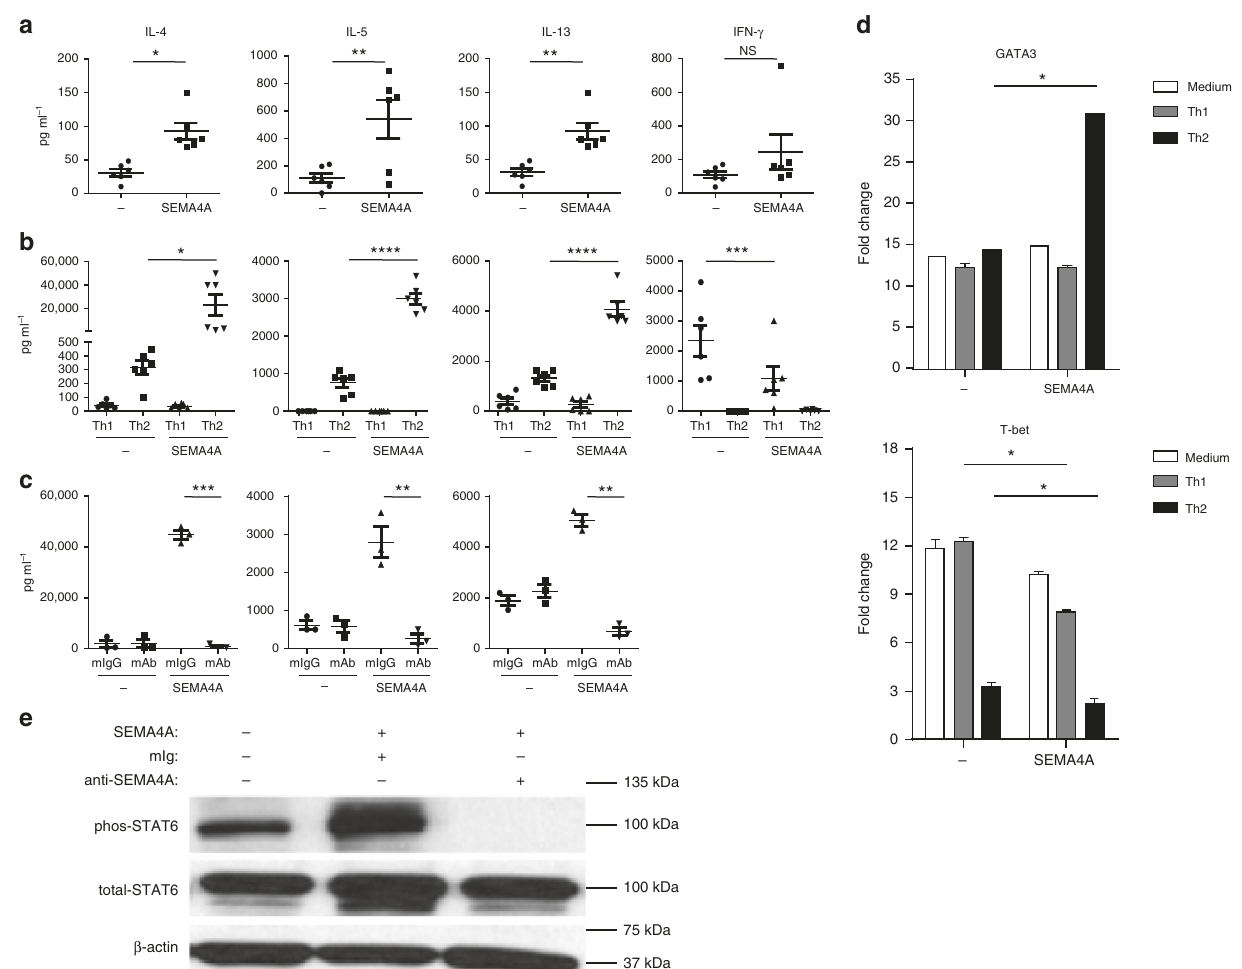
Fig. 3 SEMA4A enhances Th2 polarization of Th2-primed CD4 + T cells. a – c SEMA4A enhances Th2 cytokine production. The puri fi ed naive CD4 + T cells were cultured on parental L cells or SEMA4A-expressing L cells pre-coated with a suboptimal dose of anti-CD3 mAb, anti-CD28 mAb ( a ), or in Th1- or Th2-skewing conditions ( b ), or in Th2-skewing condition with anti-SEMA4A mAb or mIgG ( c ) for 7 days. Cultured T cells were collected and restimulated with immobilized anti-CD3, anti-CD28 for 24 h before the measurements of cytokines in the supernatants by ELISA. Each dot represents one donor. Data represent one of fi ve independent experiments. Student ’ s T -tests were used for statistical analysis, p- value was as shown, * p < 0.05, ** p < 0.01, *** p < 0.001, and **** p < 0.0001. d SEMA4A upregulates expression of GATA3 and downregulates expression of T-bet. Puri fi ed naive CD4 + T cells were cultured as in b for 2 days, and the gene expression levels were measured by real-time PCR. The relative fold differences in gene expression between samples are indicated on the y -axis. Error bars represent the s.e.m. of different wells. Data represent one of fi ve independent experiments. e SEMA4A enhances phosphorylation of SATA6. Puri fi ed naive CD4 + T cells were cultured as in c for 7 days, and then restimulated with anti-CD3, anti-CD28 for 30 min. Activated STAT6 was detected by western blot with β -actin serving as an internal control. Data represent one of four independent